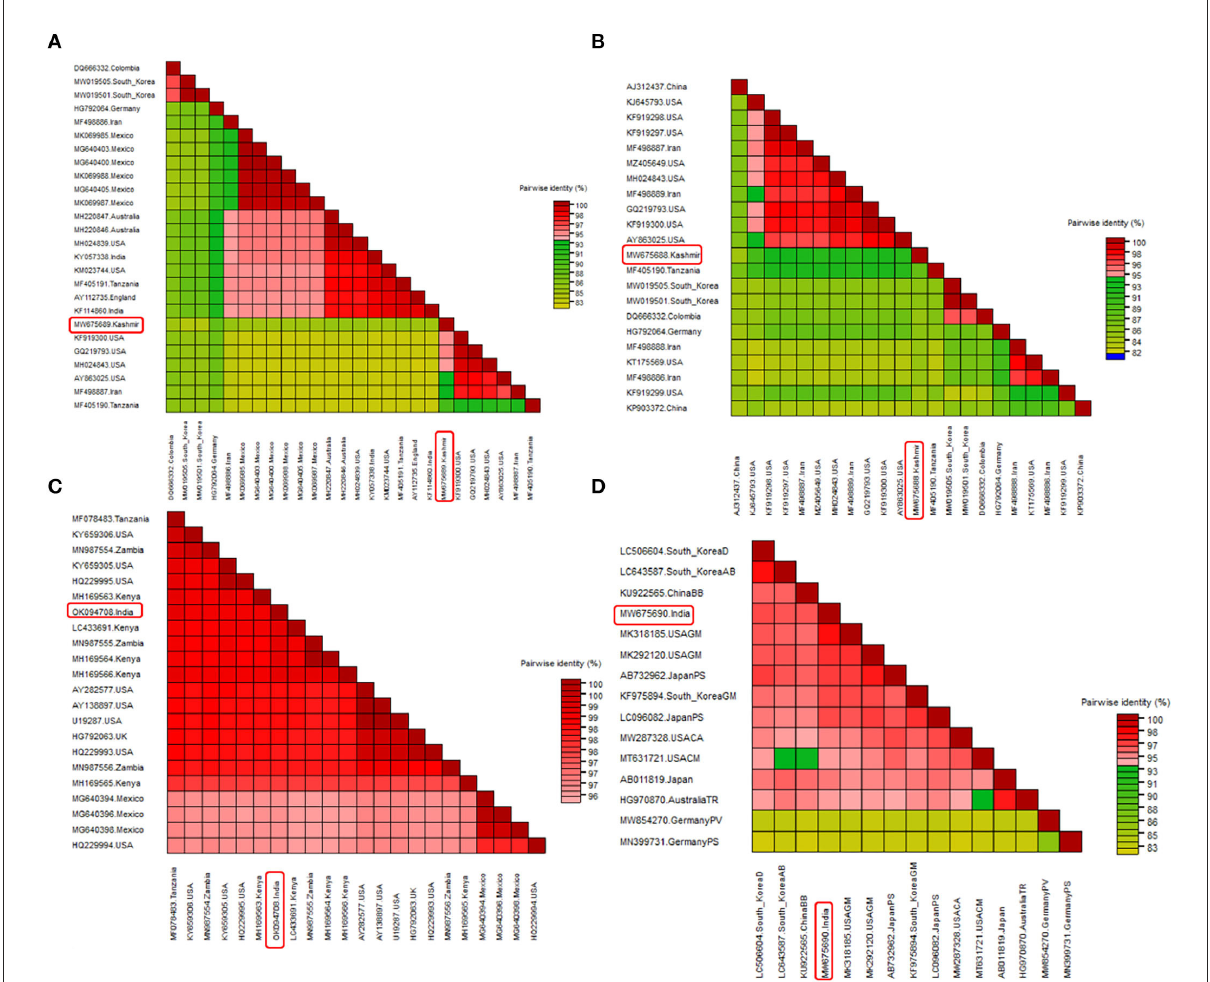
FIGURE4 Pairwise nucleotide comparison of identified viruses along with closely related genomes obtained from GenBank NCBI database. Color coded matrix was generated using SDT. Each color in the matrix represents percent identity score. (A) Pairwise comparison of BCMV 1, (B) pairwise comparison of BCMV 2, (C) pairwise comparison of BCMNV, and (D) pairwise comparison of